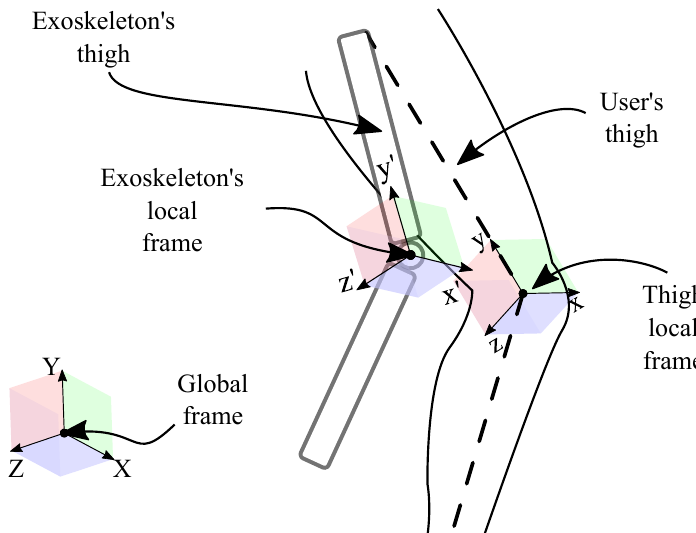
Figure 3. 2D-projection of the descriptive scheme of rotation matrices.